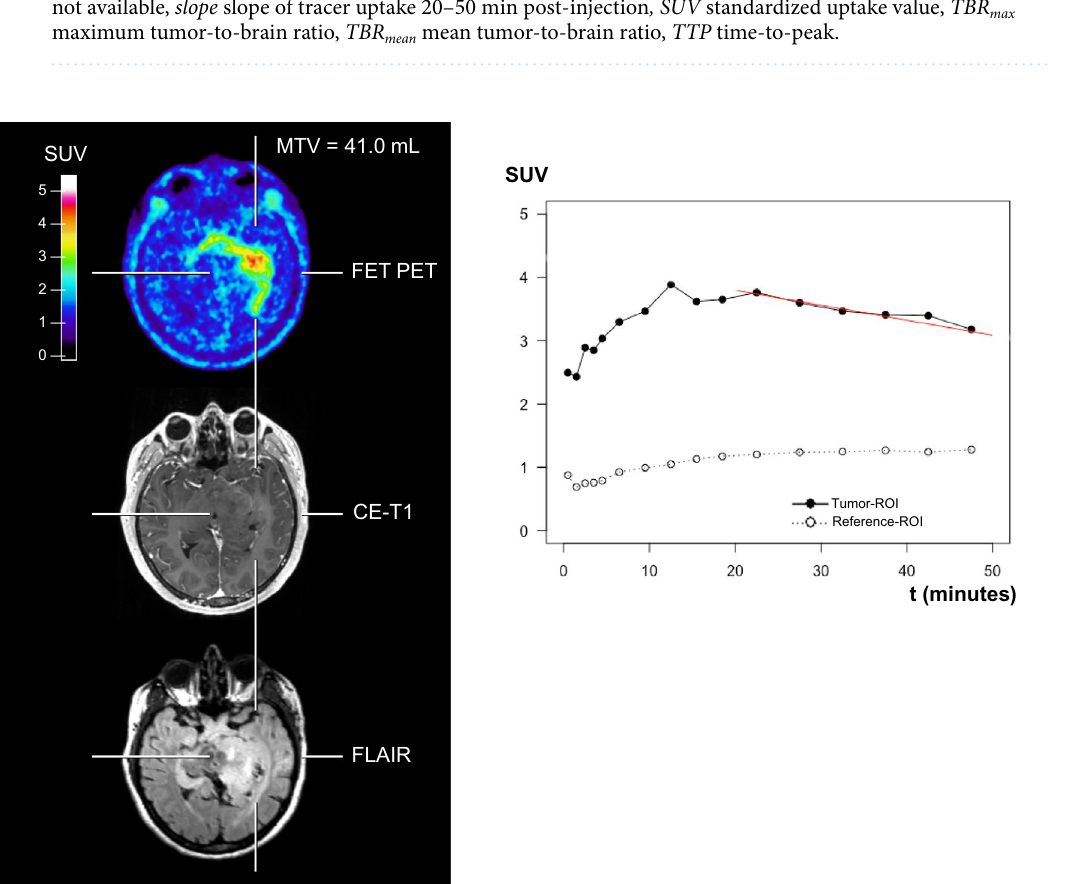
Table 2. Imaging findings. FLAIR fluid attenuated inversion recovery, MTV metabolic tumor volume, n.a. not available, slope slope of tracer uptake 20–50 min post-injection , SUV standardized uptake value, TBR max